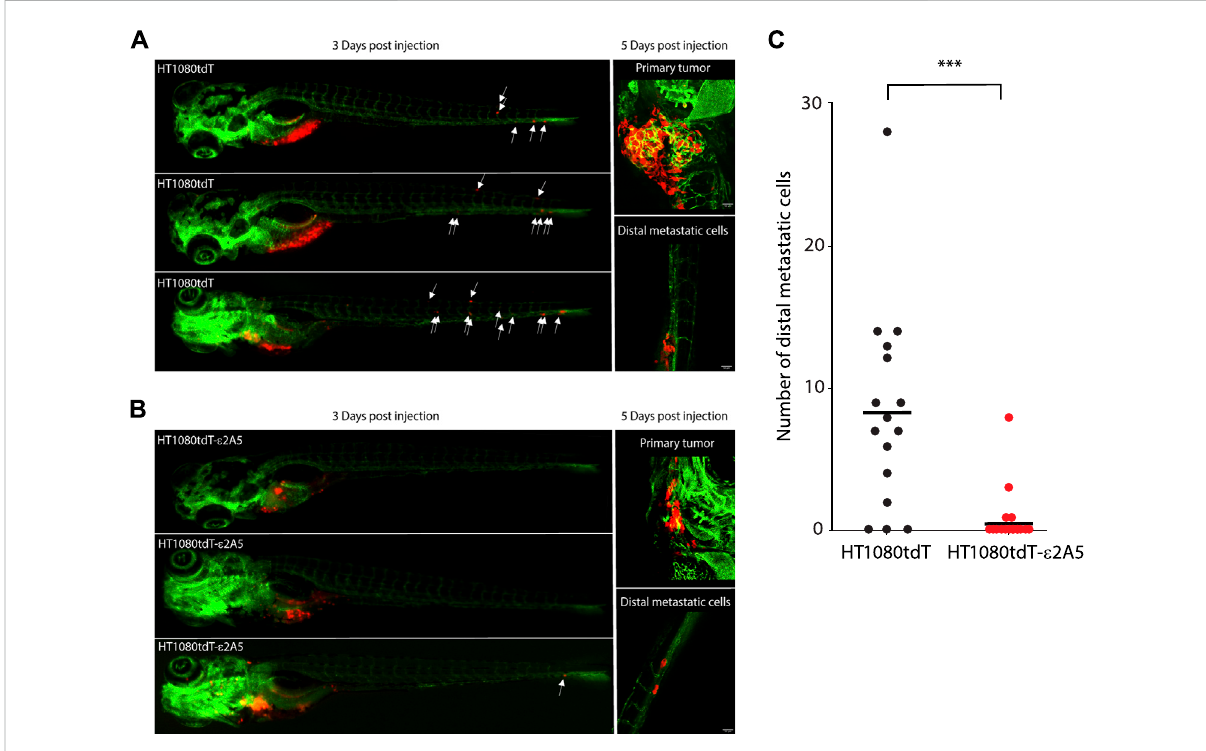
FIGURE 8 HT1080tdT cells extravasation in zebra fi sh embryos. (A) and (B) . Representative fl uorescent (left) and confocal (right) images of transgenic zebra fi shembryosTg( fl i1:EGFP)injectedwithHT1080tdTcells (A) orHT1080tdT- ε 2A5cells (B) .Fluorescentimagesweretaken3dayspostinjection, whereas confocal images were taken 5 days post injection. White arrows indicate the position of migrated HT1080tdT cells. (C) . Quanti fi cation of migratedHT1080tdTcancercells at3days postinjection;HT1080tdT,n=16;HT1080tdT- ε 2A5,n=24, *** p < 0.0001.Theimages inthe fi gure are representative of more than 3 biological